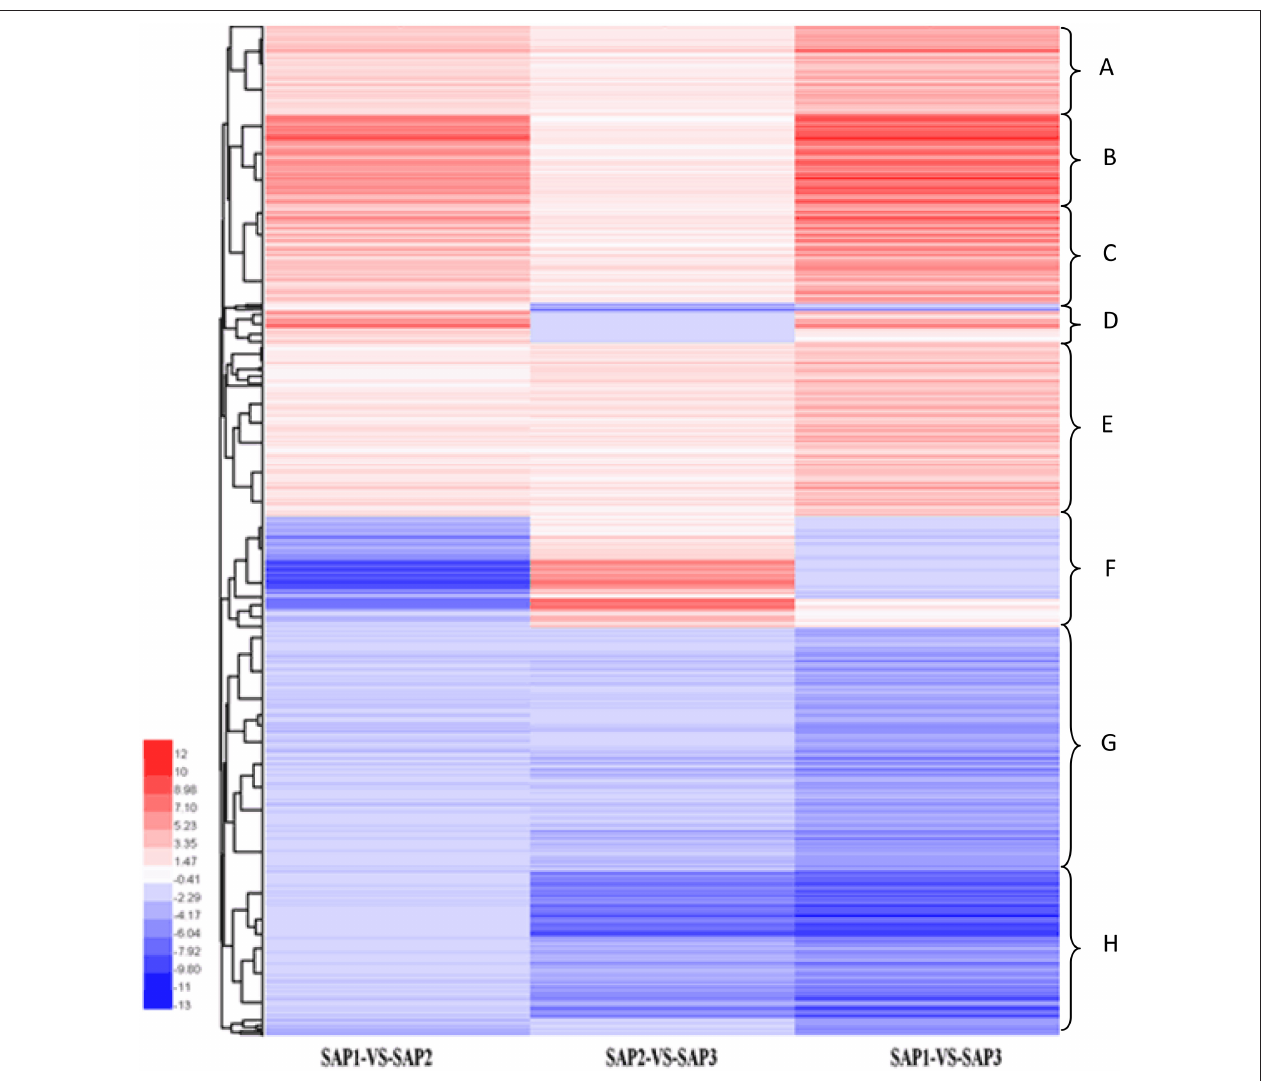
FIGURE 6 | Hierarchical cluster analysis of DEGs between different developmental stages for stem apex of primocane and floricane (SAP1 vs. SAP2, SAP2 vs. SAP3, SAP1 vs. SAP3, “a” was the control and “b” was experimental group in “a vs. b”). Each line refers to data from one gene. The color bar represents the log 10 RPKM and ranges from green (low expression) to red (high expression). The clusters from A to H indicate the eight major clusters resulting from HCE